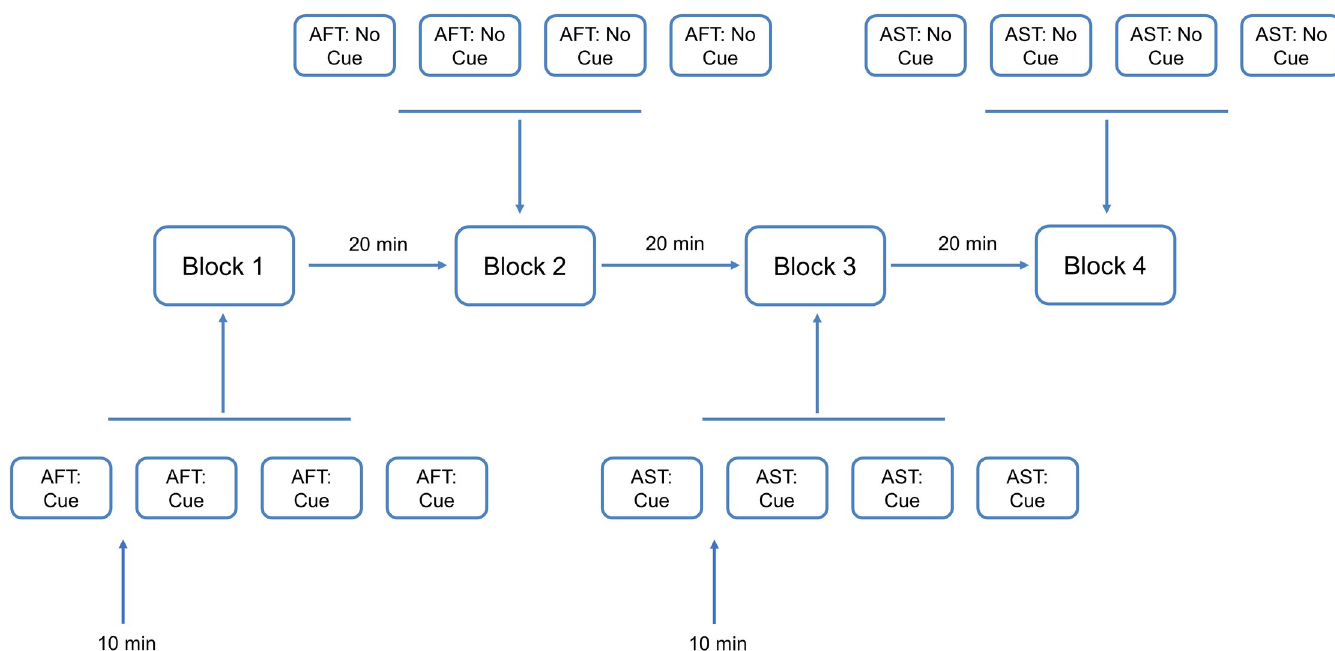
Fig 1. Timing and sequence of tapping tasks during both visits. The order of the experiments was counterbalanced using the Latin square method.